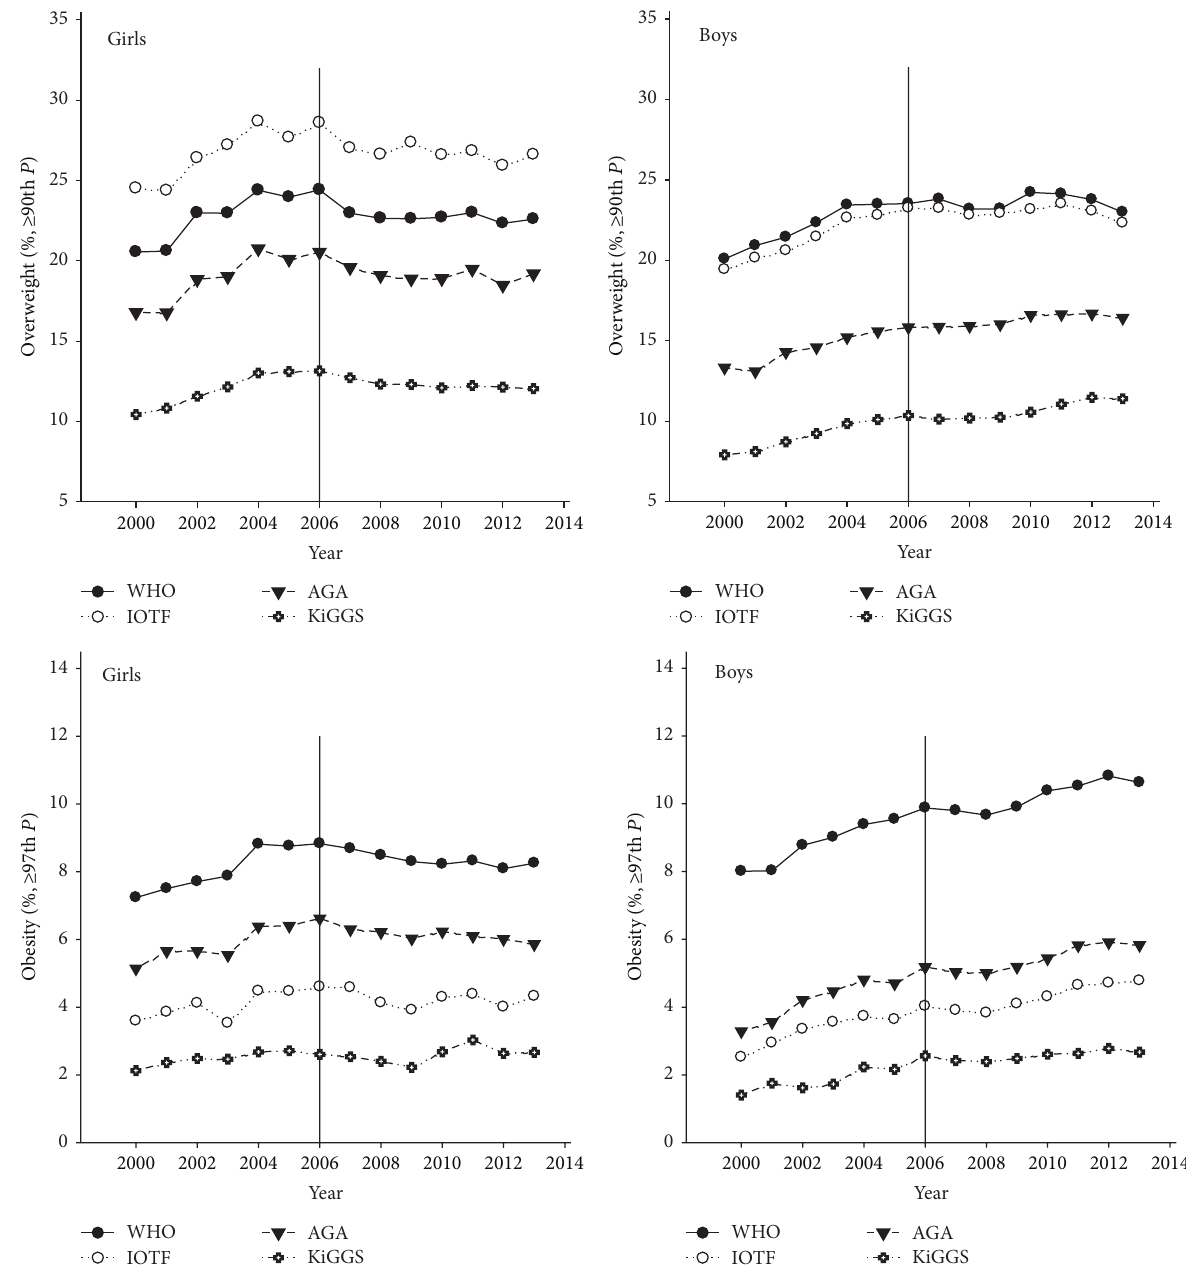
Figure 1: Prevalence (%) of overweight (including obesity) and obesity in girls and boys with T1D aged 2–18 years based on WHO, IOTF, AGA, and KiGGS reference population in the years 2000–2013, adjusted for age and diabetes duration. 𝑃 : percentile. WHO: World Health Organization. IOTF: International Obesity Task Force. AGA: German working group on obesity in childhood and adolescents. KiGGS: German Health Interview and Examination Survey for Children and